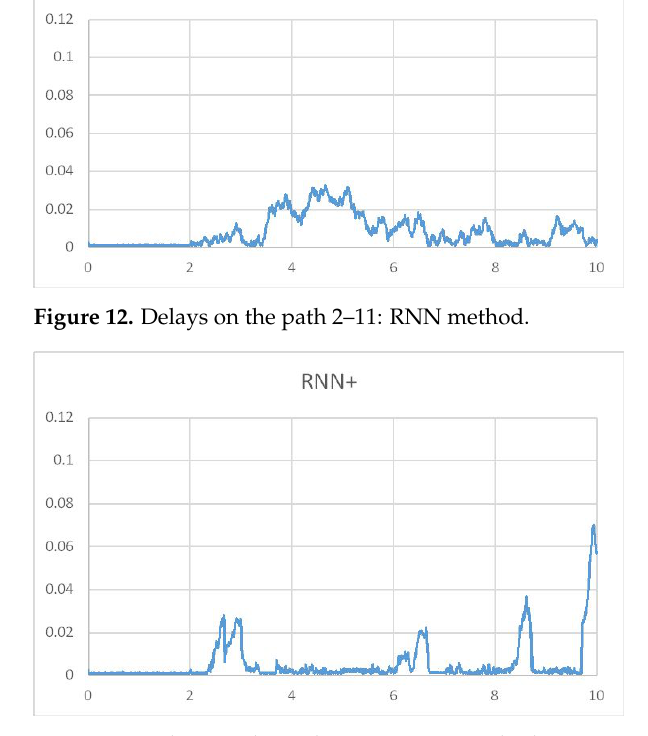
Figure 13. Delays on the path 2–11: RNN+